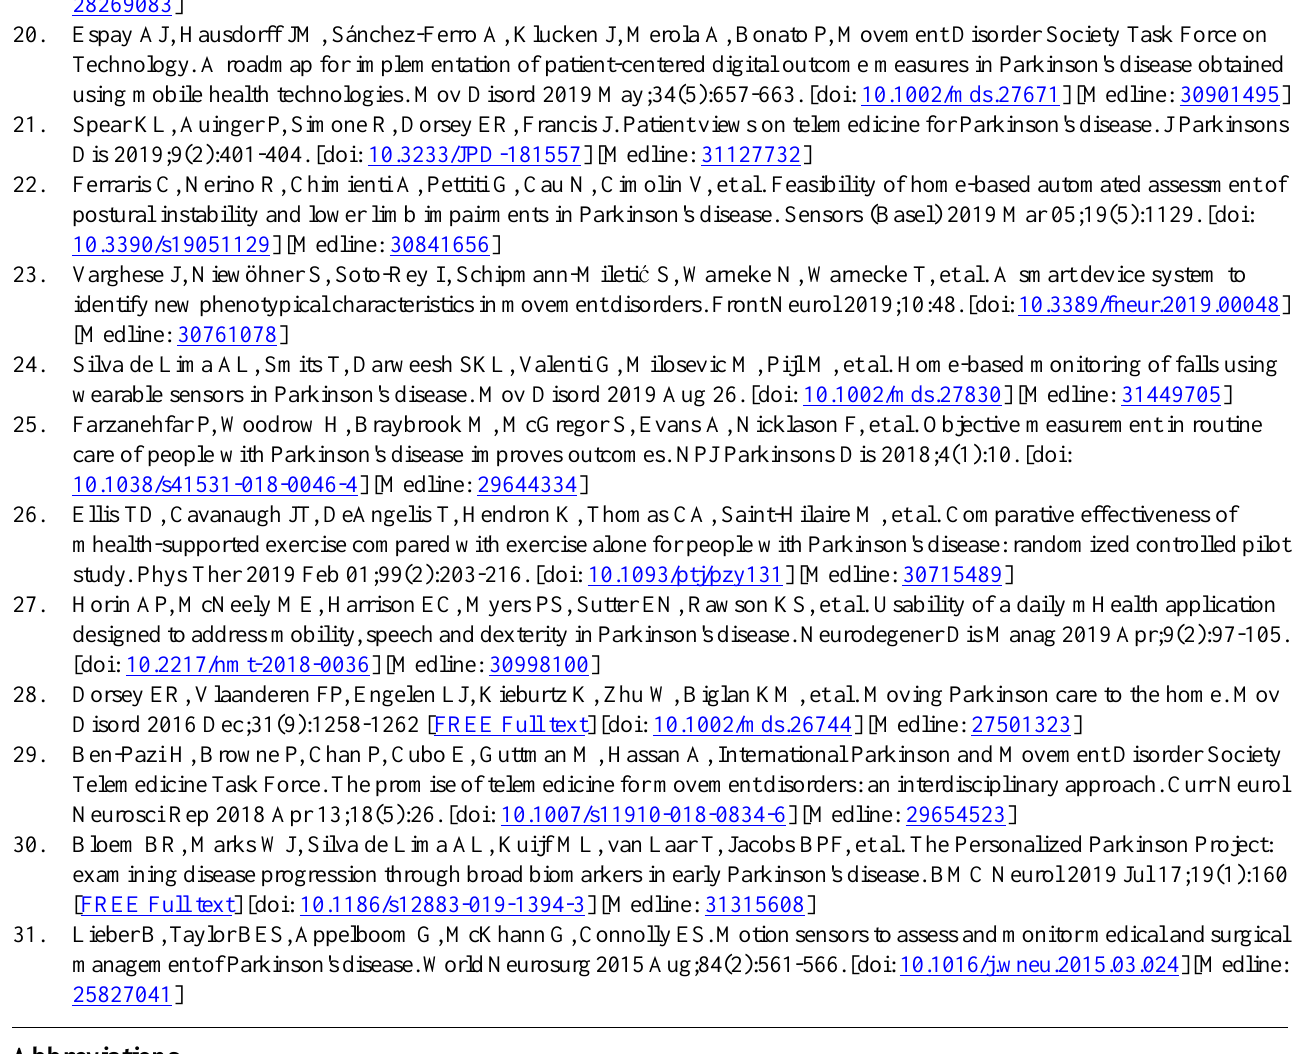
Abbreviations EQ-5D-5L: EuroQol 5-Dimension 5-Level H&Y: Hoehn and Yahr scale NMSS: Non-motor symptoms scale PD: Parkinson disease PDQ-8: Parkinson's Disease Questionnaire-8 UPDRS: Unified Parkinson’s Disease Rating